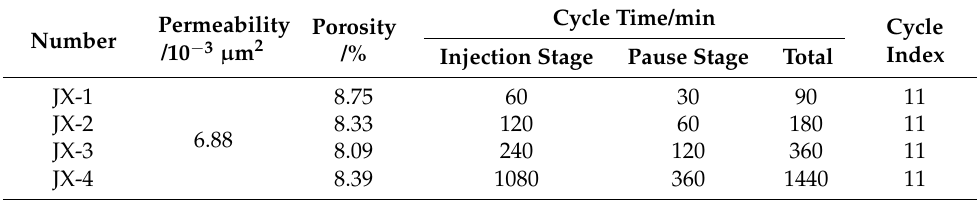
Table 2. Experimental schemes of IGI.